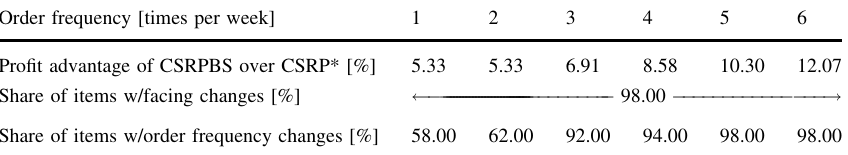
Table 6 Profit advantage of CSRPBS over CSRP* and changes in solution structure Order frequency [times per week] 1 Profit advantage of CSRPBS over CSRP* [%] Share of items w/facing changes [%] Share of items w/order frequency changes